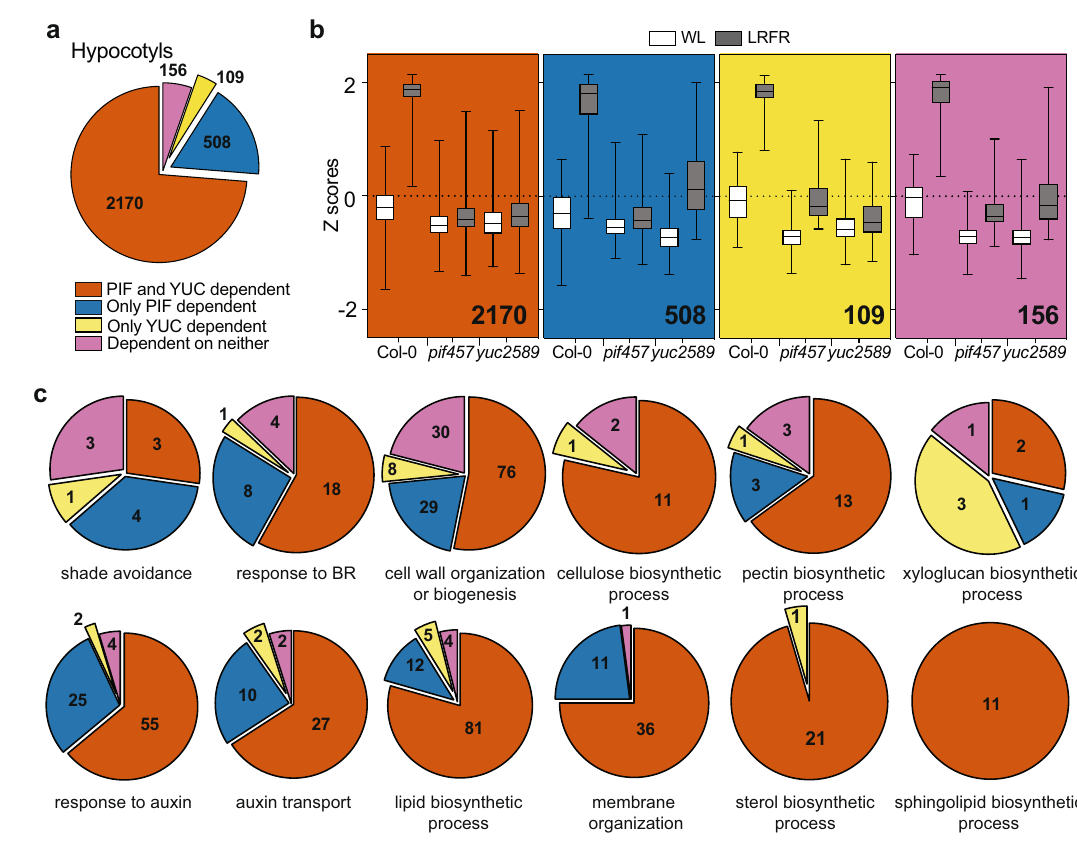
Fig. 2 | Most LRFR-induced genes in hypocotyls require both PIFs and YUCs. a The distribution of hypocotyl-induced genes in LRFR according to the dependence on PIFs and YUCs using the comparison of Col-0, pif457 , and yuc2589 transcriptomes(FDR<0.05, F testwithposthoctest). b Distributionsof Z-scores computed from replicate averages for categories shown in ( a ). The horizontal bar represents the median; boxes extend from the 25th to the 75th